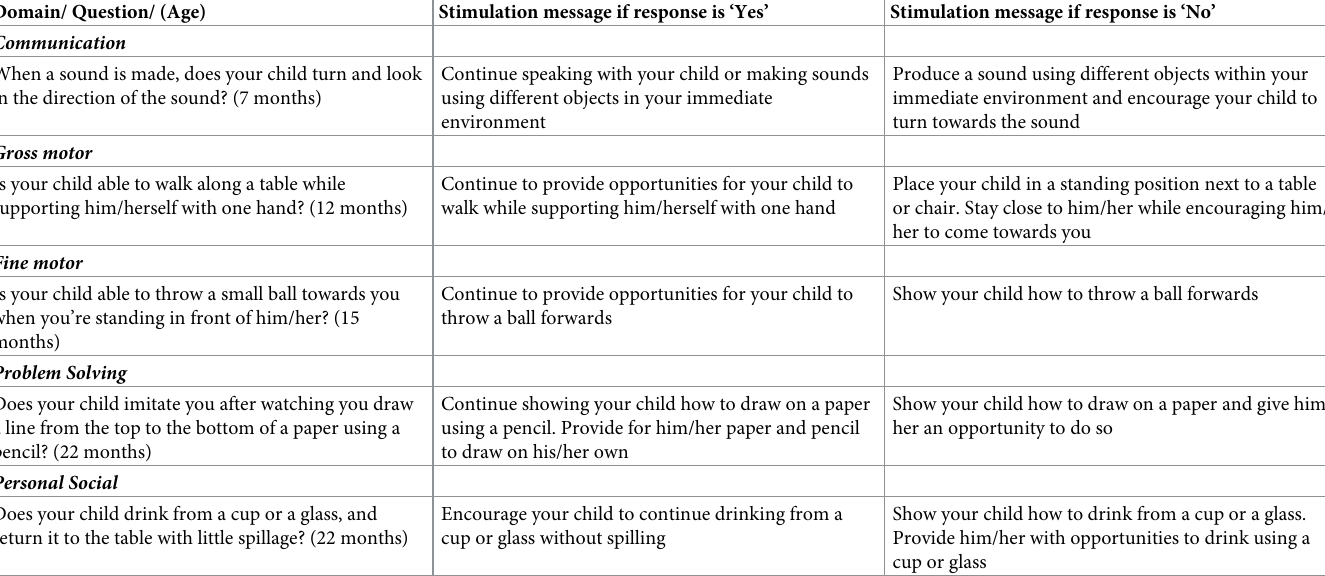
Table 1. Examples of questions and stimulation